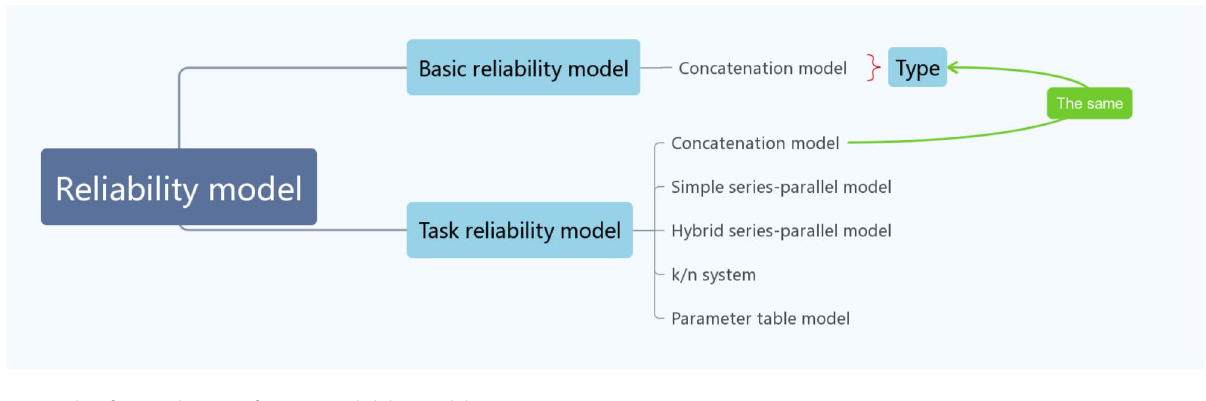
Fig. 1 Classification diagram of common reliability